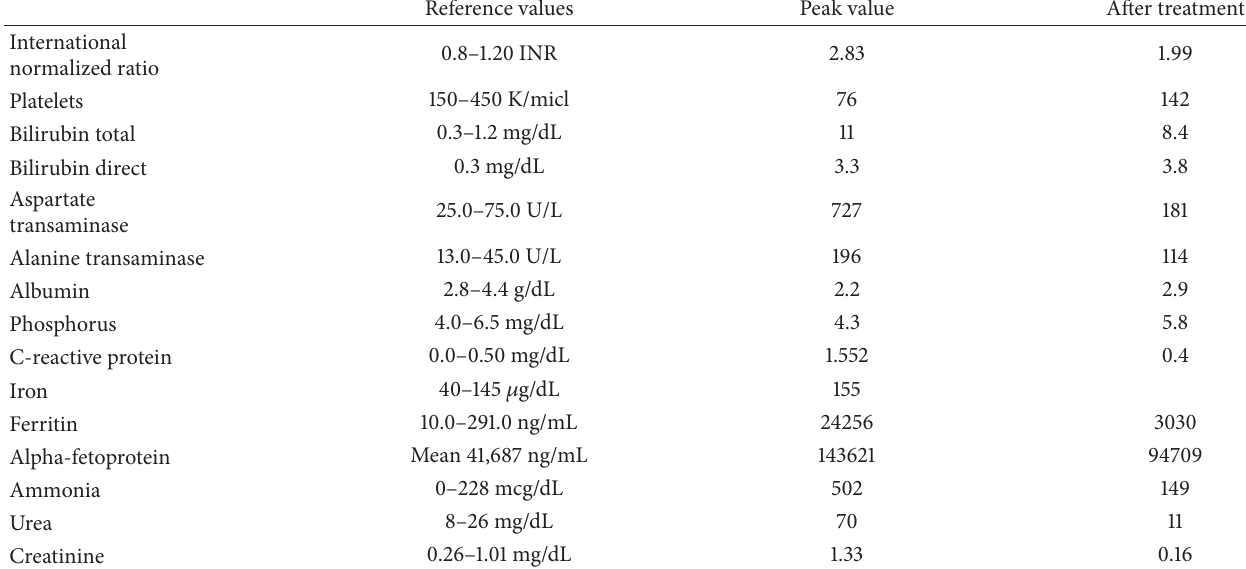
Table 1: Laboratory values before and after